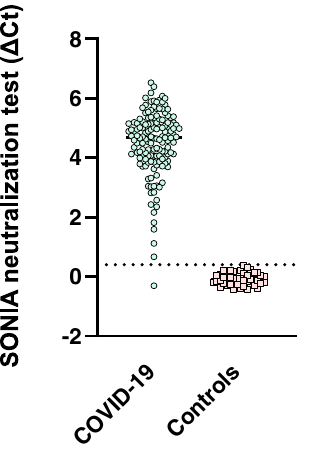
Fig. 3 NAb reactivity in convalescent COVID-19 and control sera with non-COVID-19 infection by the SONIA neutralization PCR test. Convalescent COVID-19 sera ( N = 144) were from patients 14 days after symptom onset (blue circle), and control sera ( N = 43) from patients with HCV, fl avivirus infection and Lyme disease (pink square). The y-axis is the SONIA neutralization PCR test signal Δ Ct calculated by subtracting the Ct value of the sample from that of a buffer only blank control.